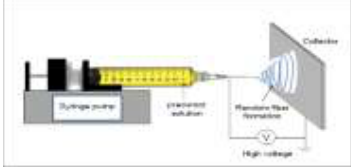
Figure 1: The schematic diagram electrospinning process to produce TiO2